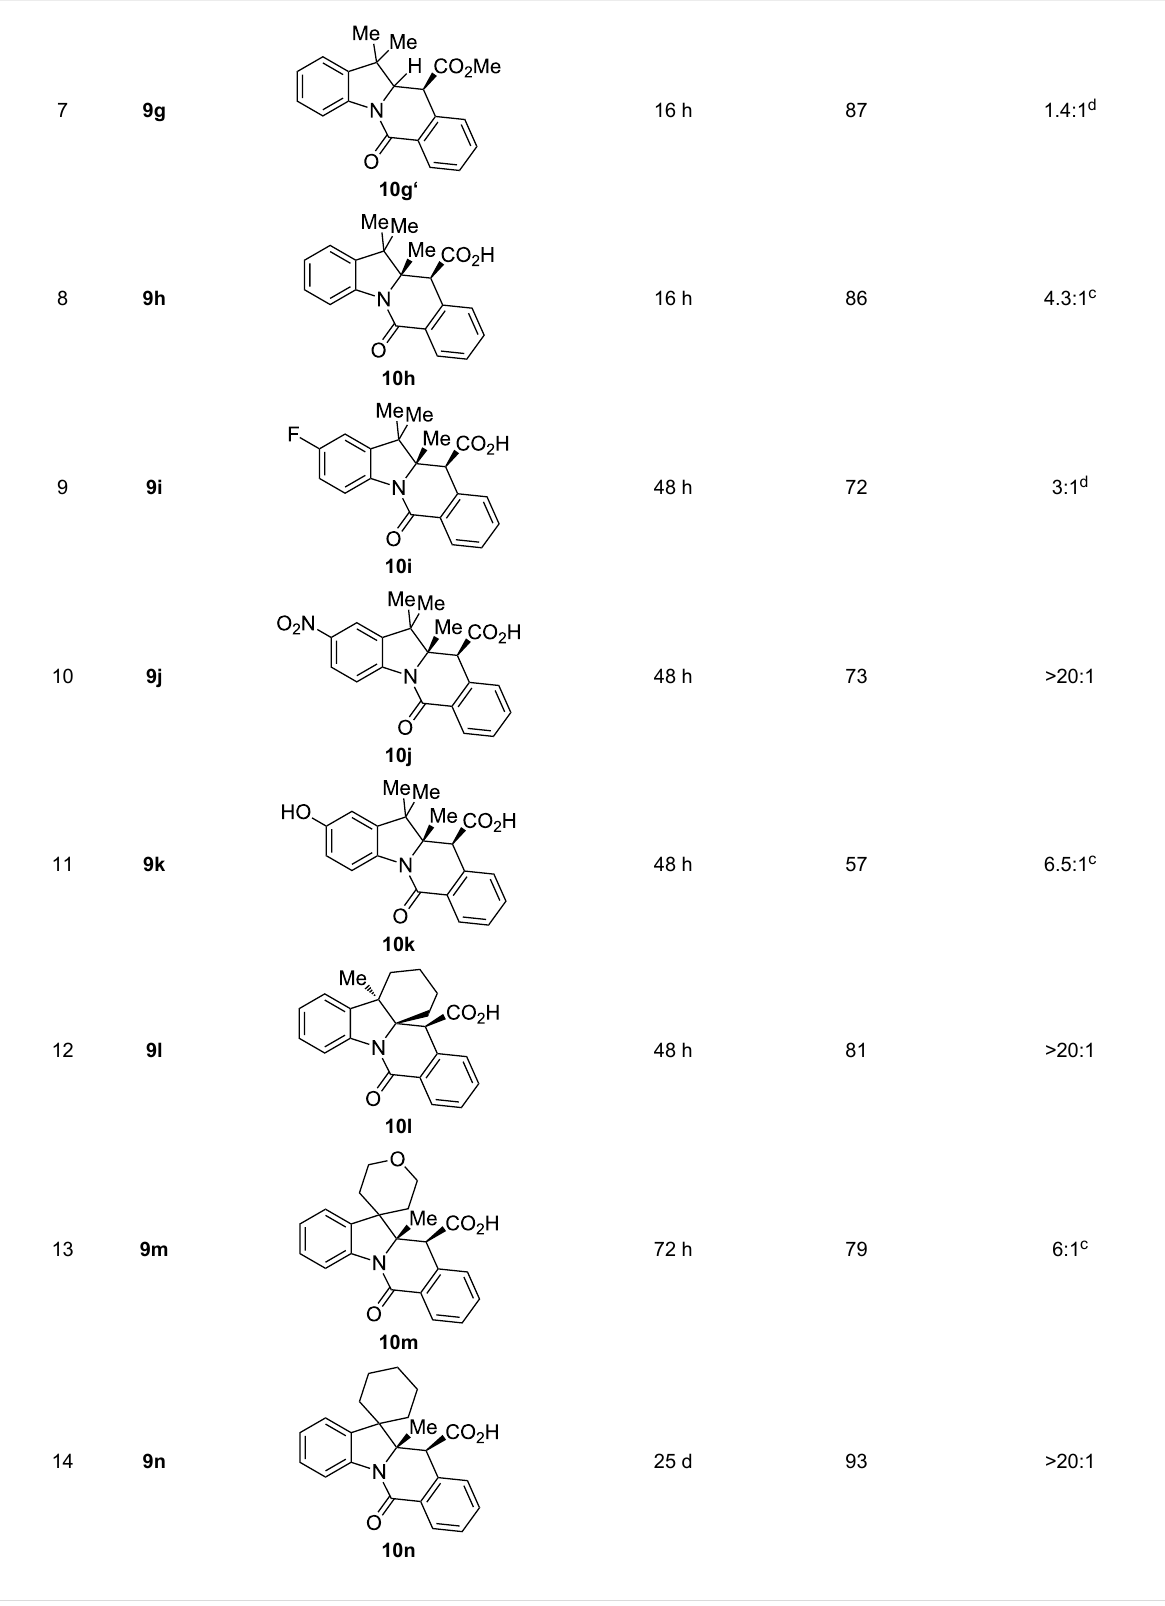
Table 1: Indolo[1,2- b ]isoquinolonic acids 10 obtained via the CCR of indolenines 9 .